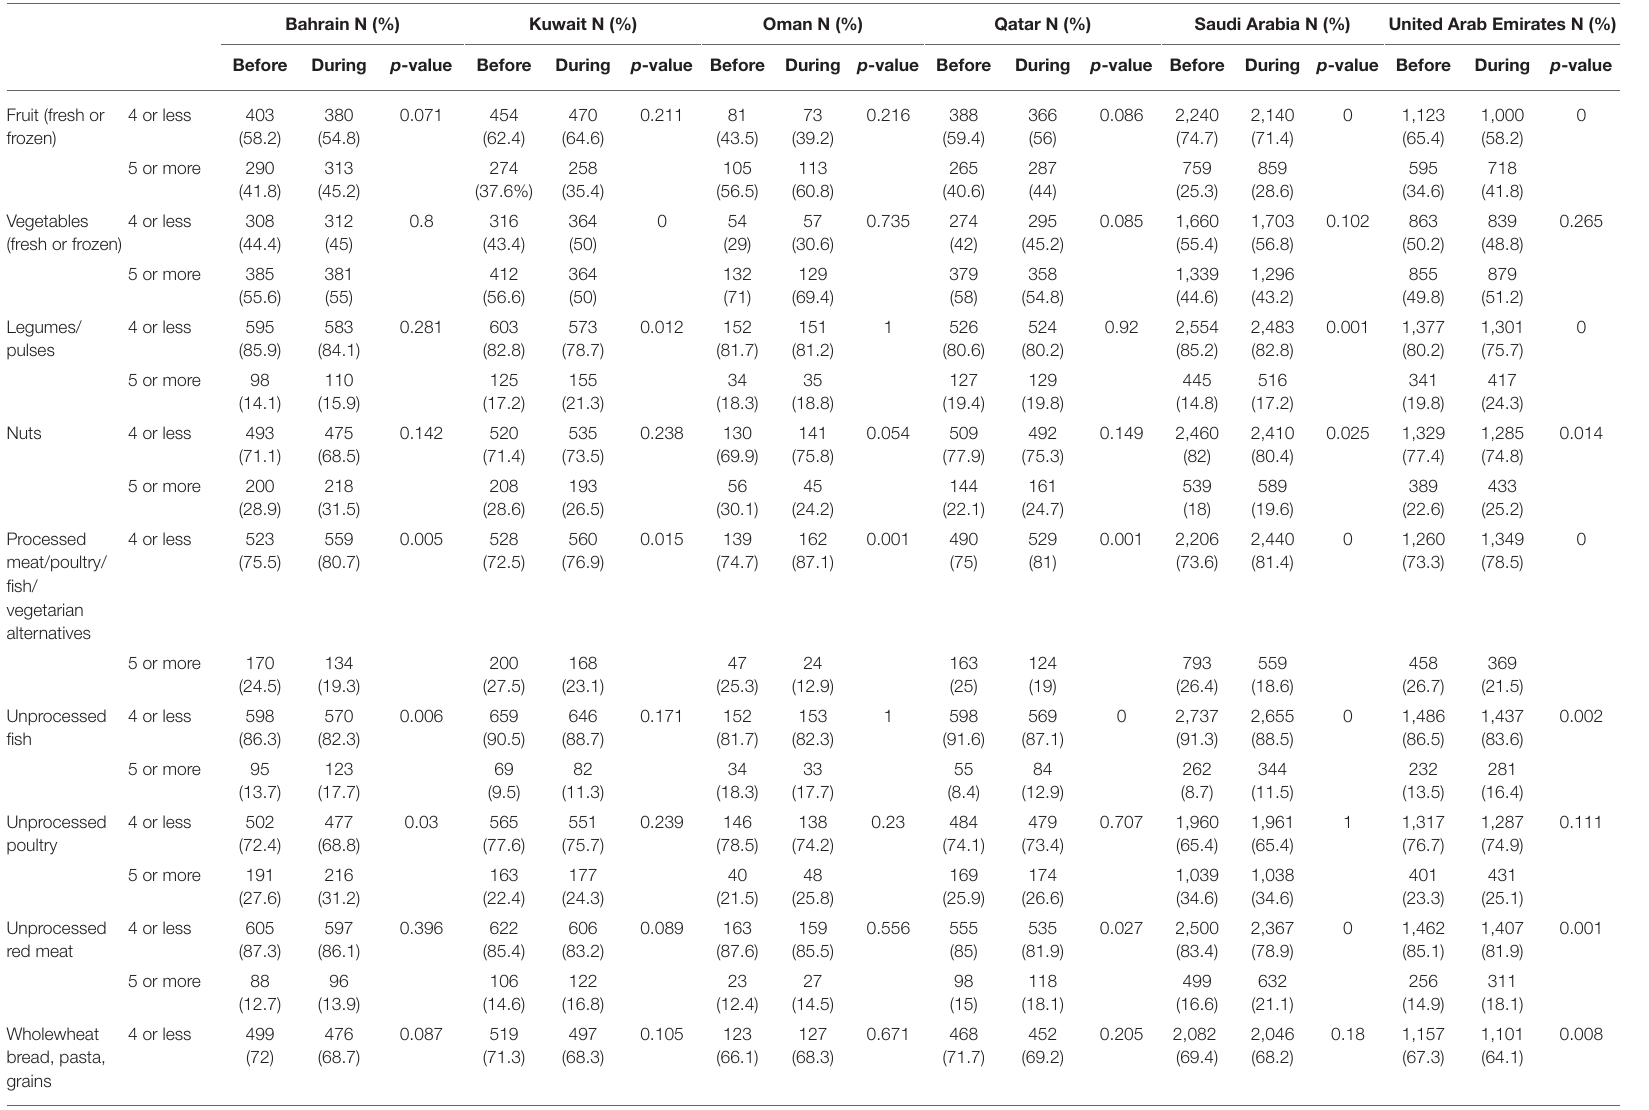
TABLE 3 | Food groups consumption among countries in the GCC region, before and during COVID-19 pandemic. Bahrain N (%) Kuwait N (%) Oman N (%) Qatar N (%) Saudi Arabia N (%) United Arab Emirates N